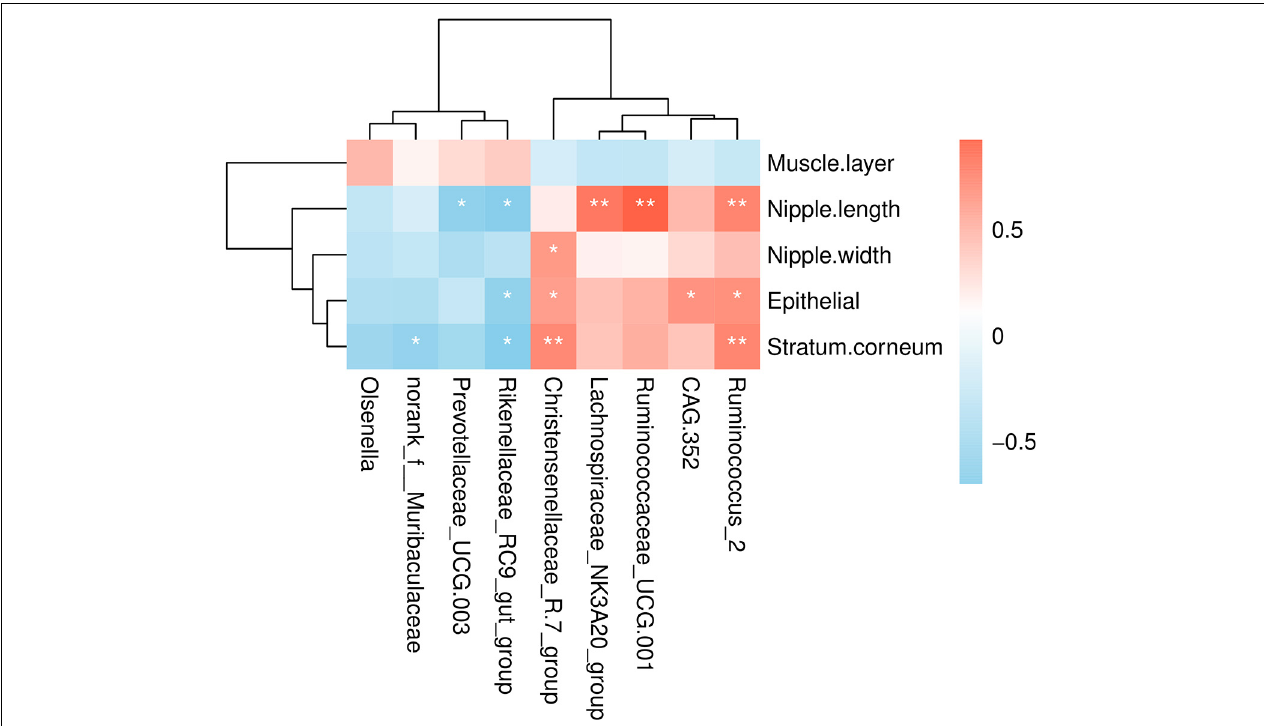
FIGURE 4 | Correlations analysis between ruminal development indicators and rumen bacteria. Rows and columns represent the indicated ruminal development indicator and genus, respectively. Each lattice represents a Pearson correlation coefficient between an indicator with a genus. Red and blue denote positive and negative correlation, respectively. * P < 0.05, ** P <